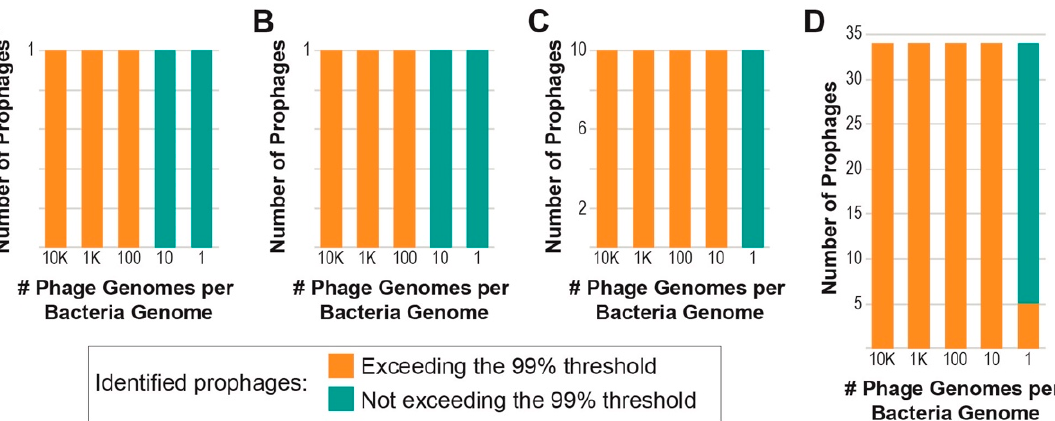
Figure 2. Induced prophages identified for a single bacterium ( A ) and mock communities ( B – D ). In the first test ( A ), a single prophage sequence with 100× genome coverage was added to bacterial reads producing a PtoH ratio of 10,000:1, 1000:1, 100:1, 10:1, and 1:1. ( B ) The same prophage sequence used in our prior test, again represented by reads at a 100× genome coverage, were added to reads from seven bacterial strains; each strain independently was sampled to produce the 5 different PtoH ratios tested. ( C ) A total of 10 prophage sequences and the seven bacterial genomes were examined at five different PtoH ratios. ( D ) 34 prophage sequences and the seven bacterial genomes were examined at five different PtoH ratios. For all charts, if the prophage(s) were identified and met/exceeded the 99% threshold, they are shown in orange. If they did not meet/exceed the threshold, they are represented by green.